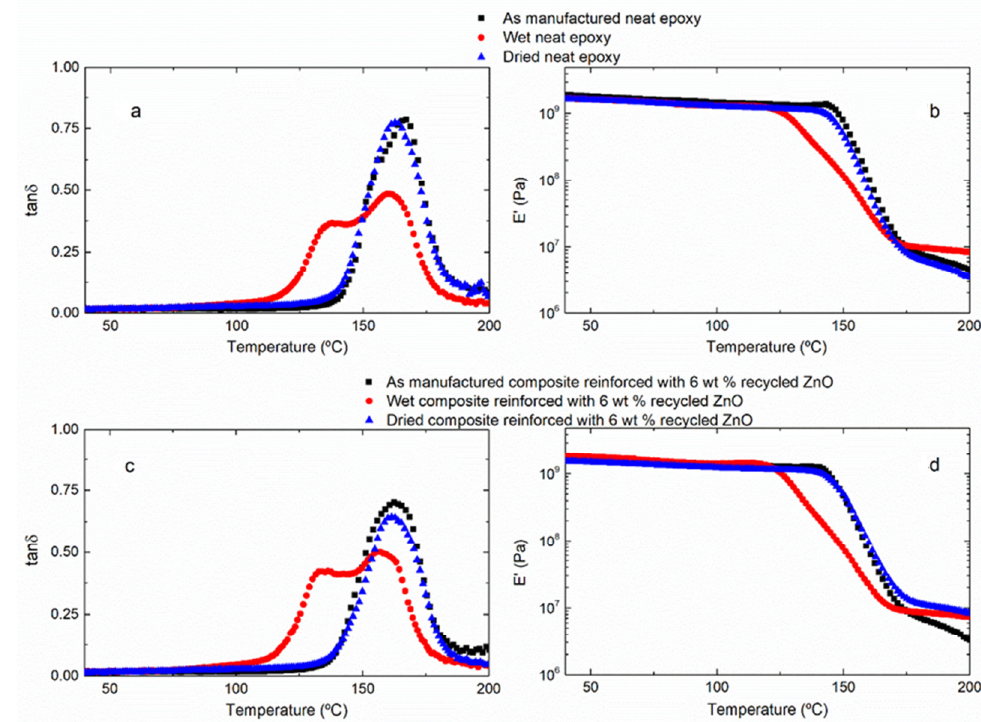
Figure 4. DMTA curves of neat epoxy thermoset ( a , b ) and composites reinforced with 6 wt% recy- cled ZnO ( c , d ) in different three stages: initial, aged and dried. ZnO ( c , d ) in different three stages: initial, aged and